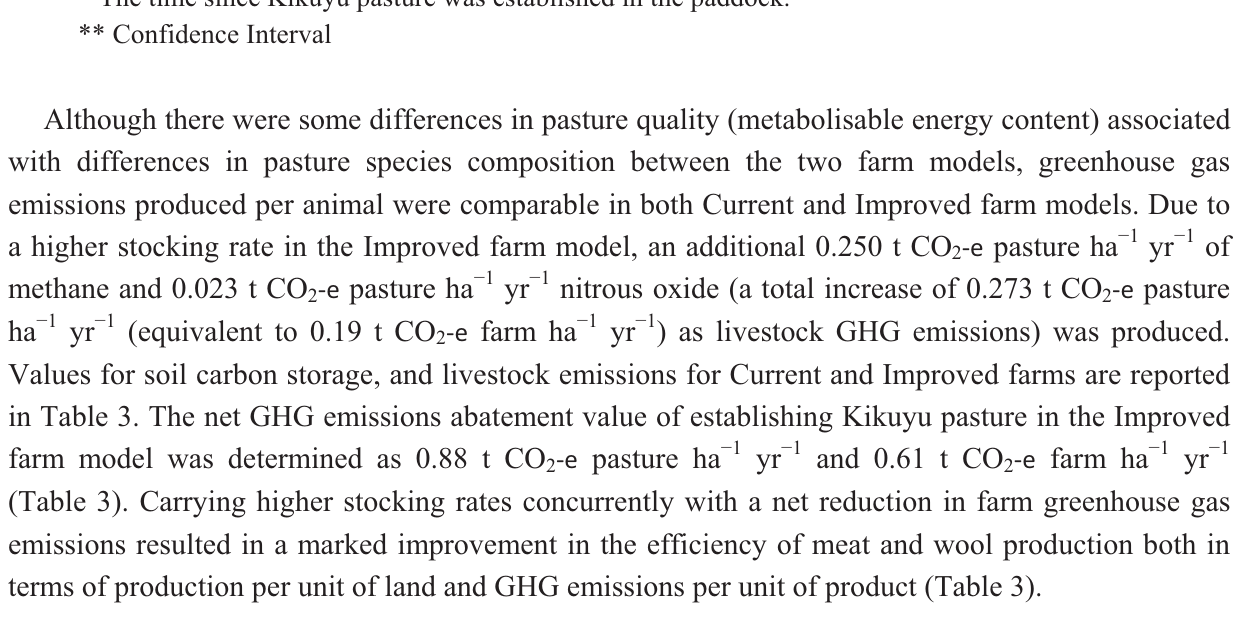
Table 3. Carbon balance and livestock production efficiency of Current and Improved farm systems. Livestock production values for both Current and Improved farms were taken from the GrassGro simulation